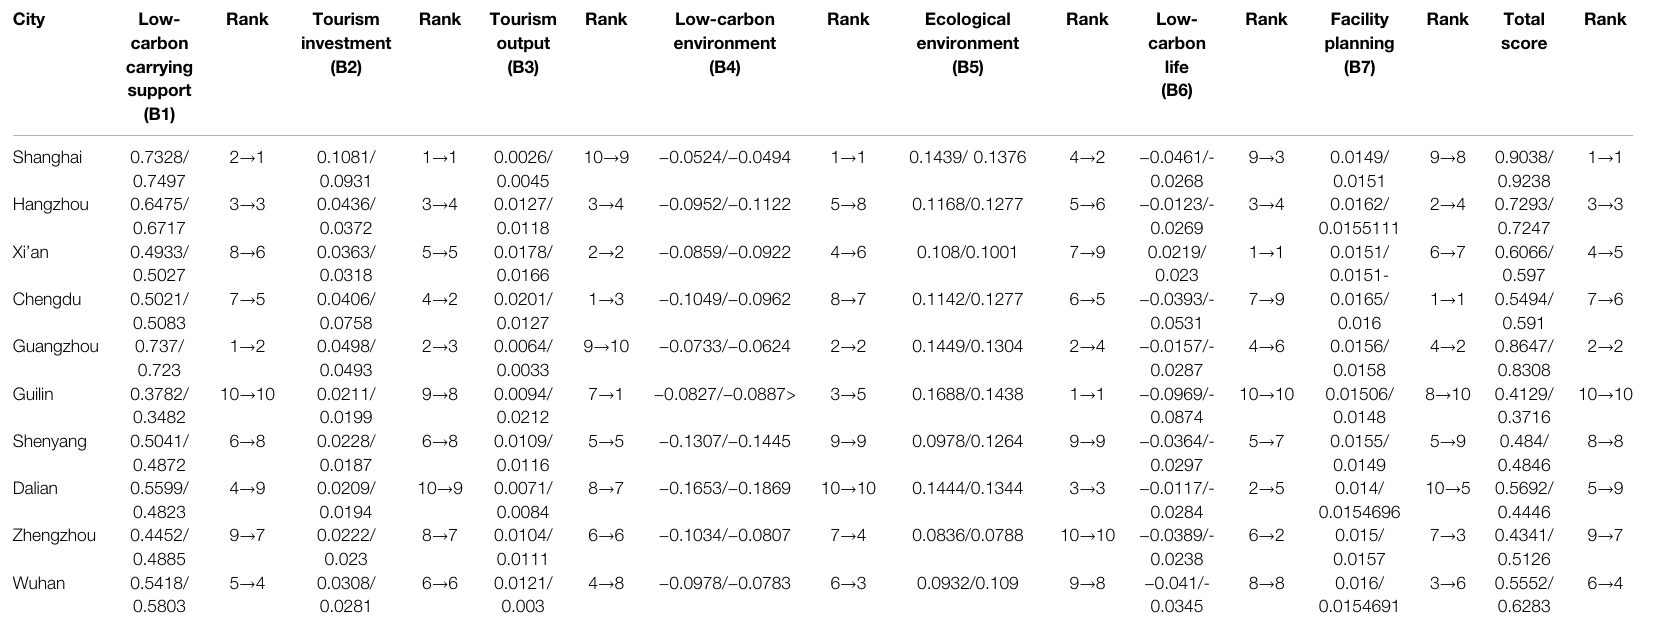
Examples of table data: a/b, 1 → 2, means that a is the score in 2014 and b is the score in 2019, and the ranking has changed from 1st to